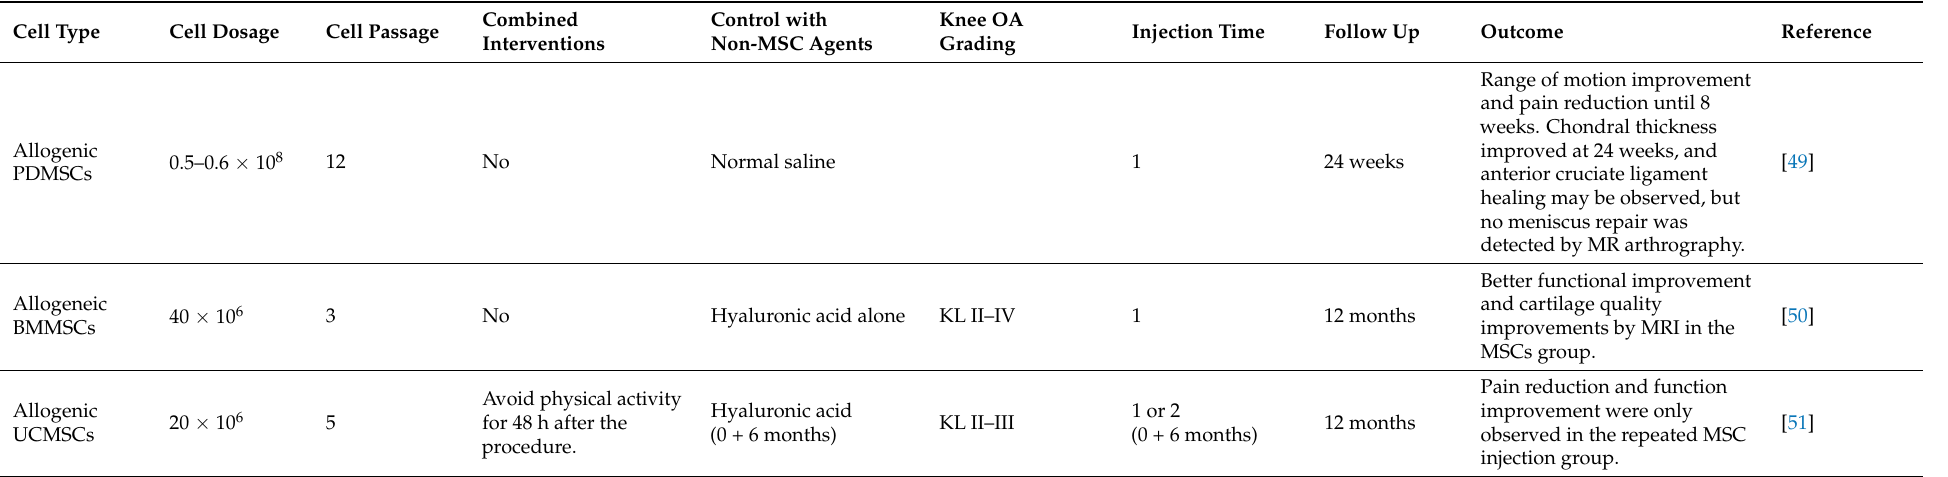
Table 1. Substance comparison injection studies using allogeneic